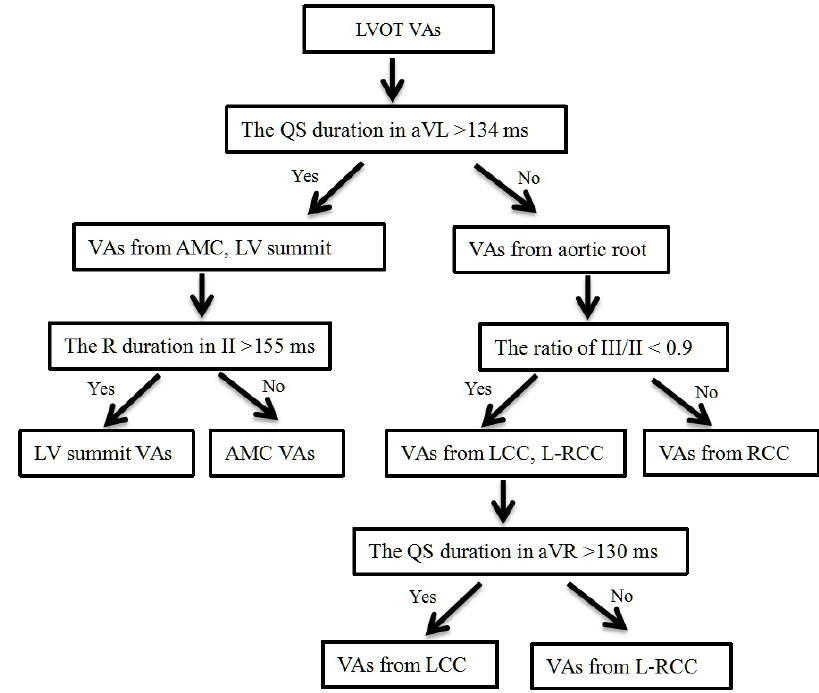
Figure 3. Flowchart of 4-stepwise electrocardiographic algorithm.